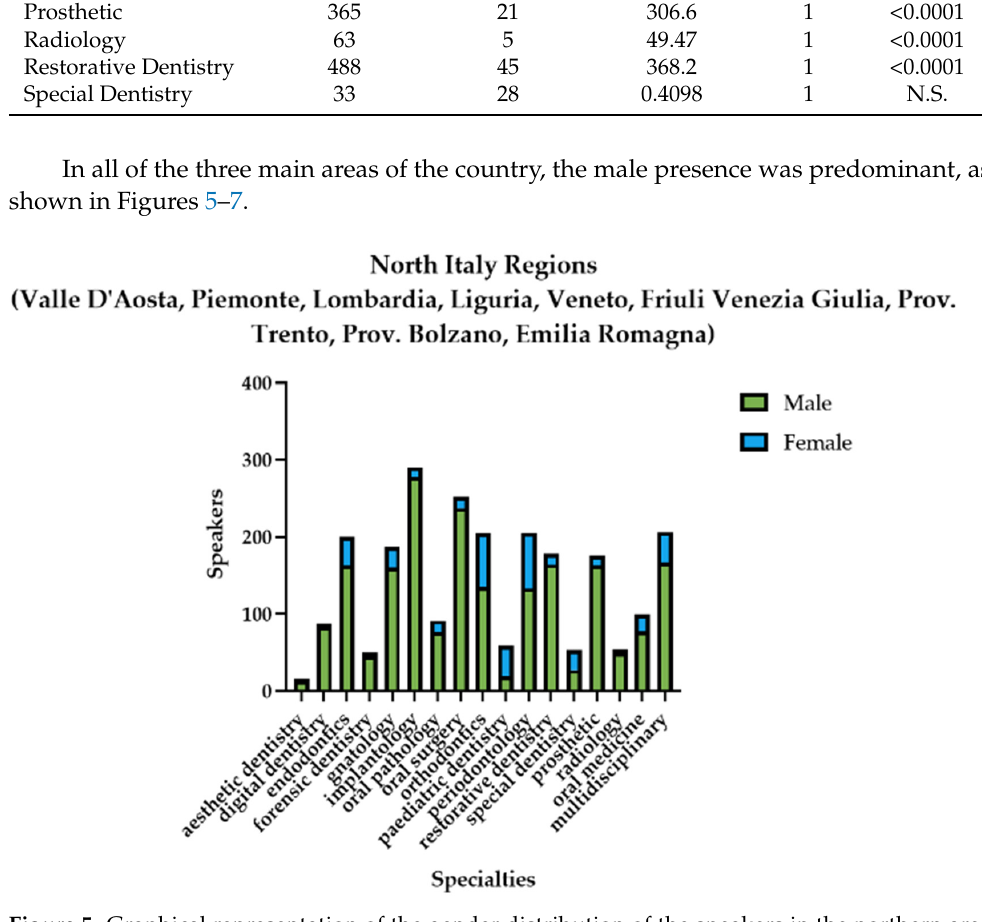
Figure 5. Graphical representation of the gender distribution of the speakers in the northern area of Italy.